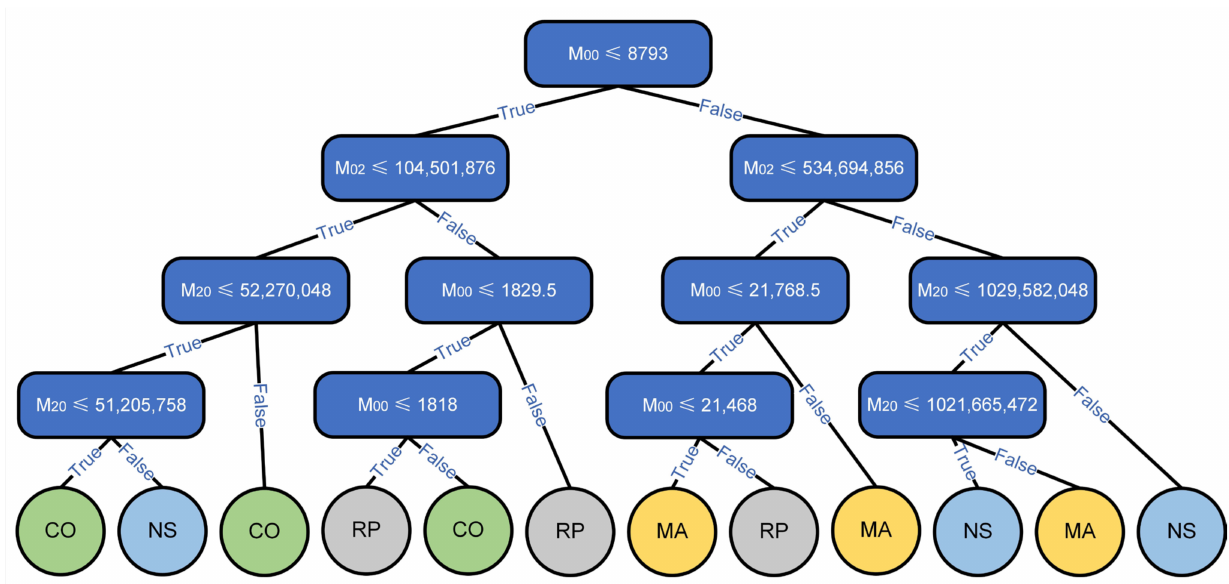
Figure 9. Trained decision tree in the